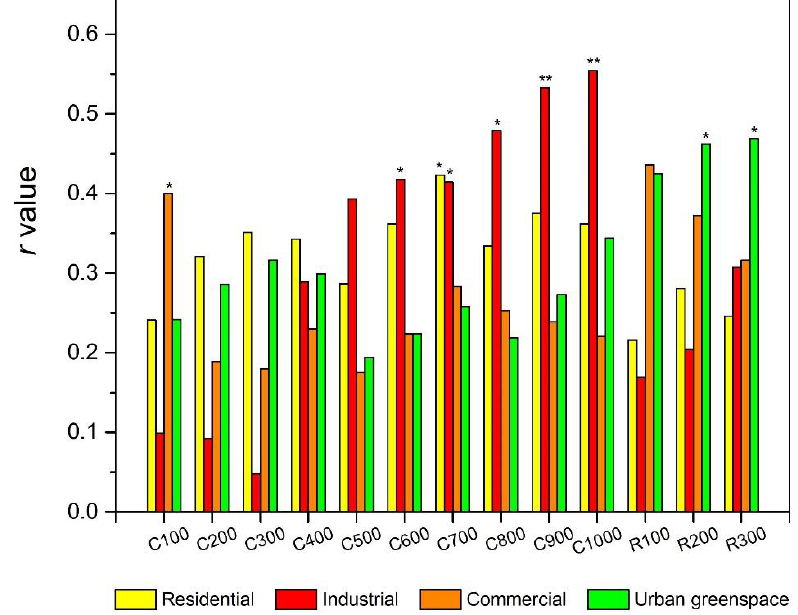
Figure 7. Correlations between TP and the areas of particular land uses under the circular and riparian buffer scales at different spatial scales based on a Spearman’s rank correlation analysis. The one-asterisk (two-asterisk) superscripts denote above 90% (95%) confidence levels. Note that only the land uses that significantly correlated with the TP were shown.